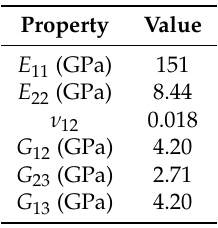
Table 2. Mechanical properties of the composite material.